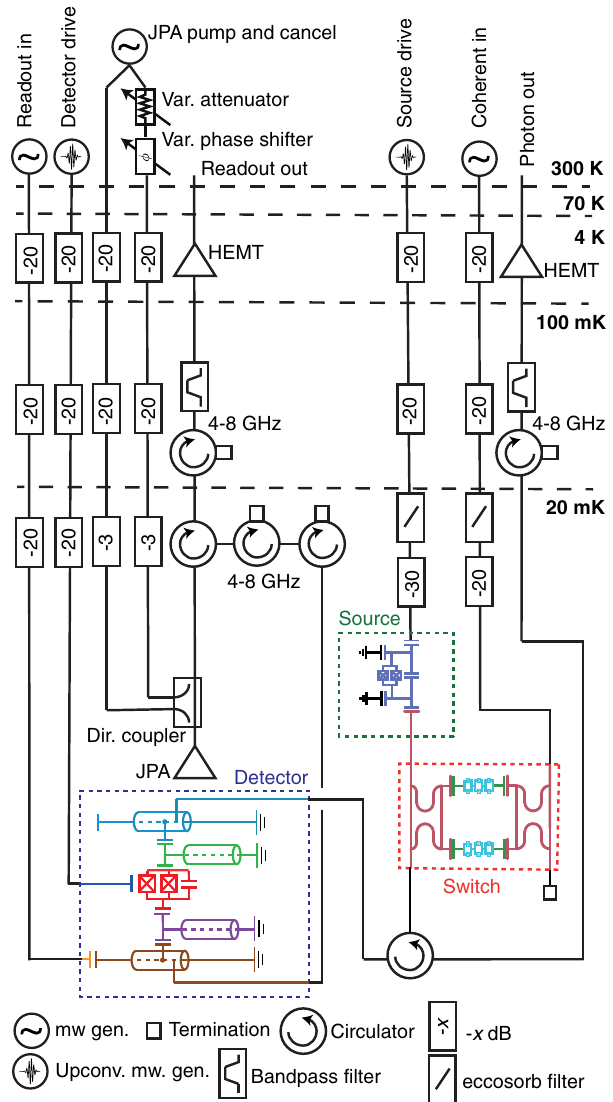
FIG. 6. Scheme of the experimental setup. All microwave lines are inner and outer dc blocked at the room-temperature flange of the cryogenic system. Source and switch are physically on the same sample. The dc cabling for applying external magnetic fields with two coils on the switch sample holder and one coil at the detector is not